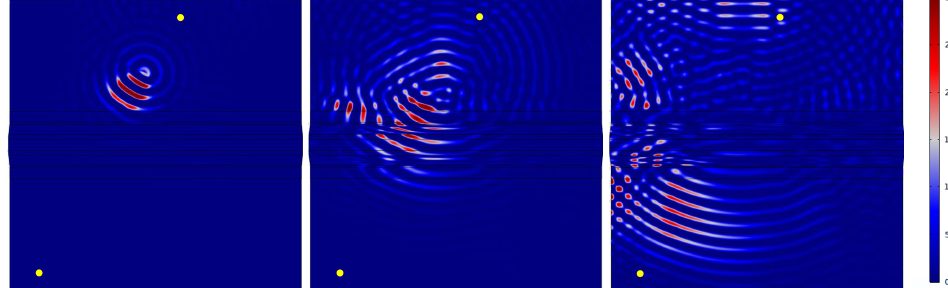
Figure 19. Exemplary representation of the wave propagation in the test specimen. The wave field of the differential signal (undamaged–damaged) is shown for a damage of size 671 mm 2 at position D1 and the actuator-sensor path T4–T7. The time steps 150 µ s, 250 µ s and 350 µ s were